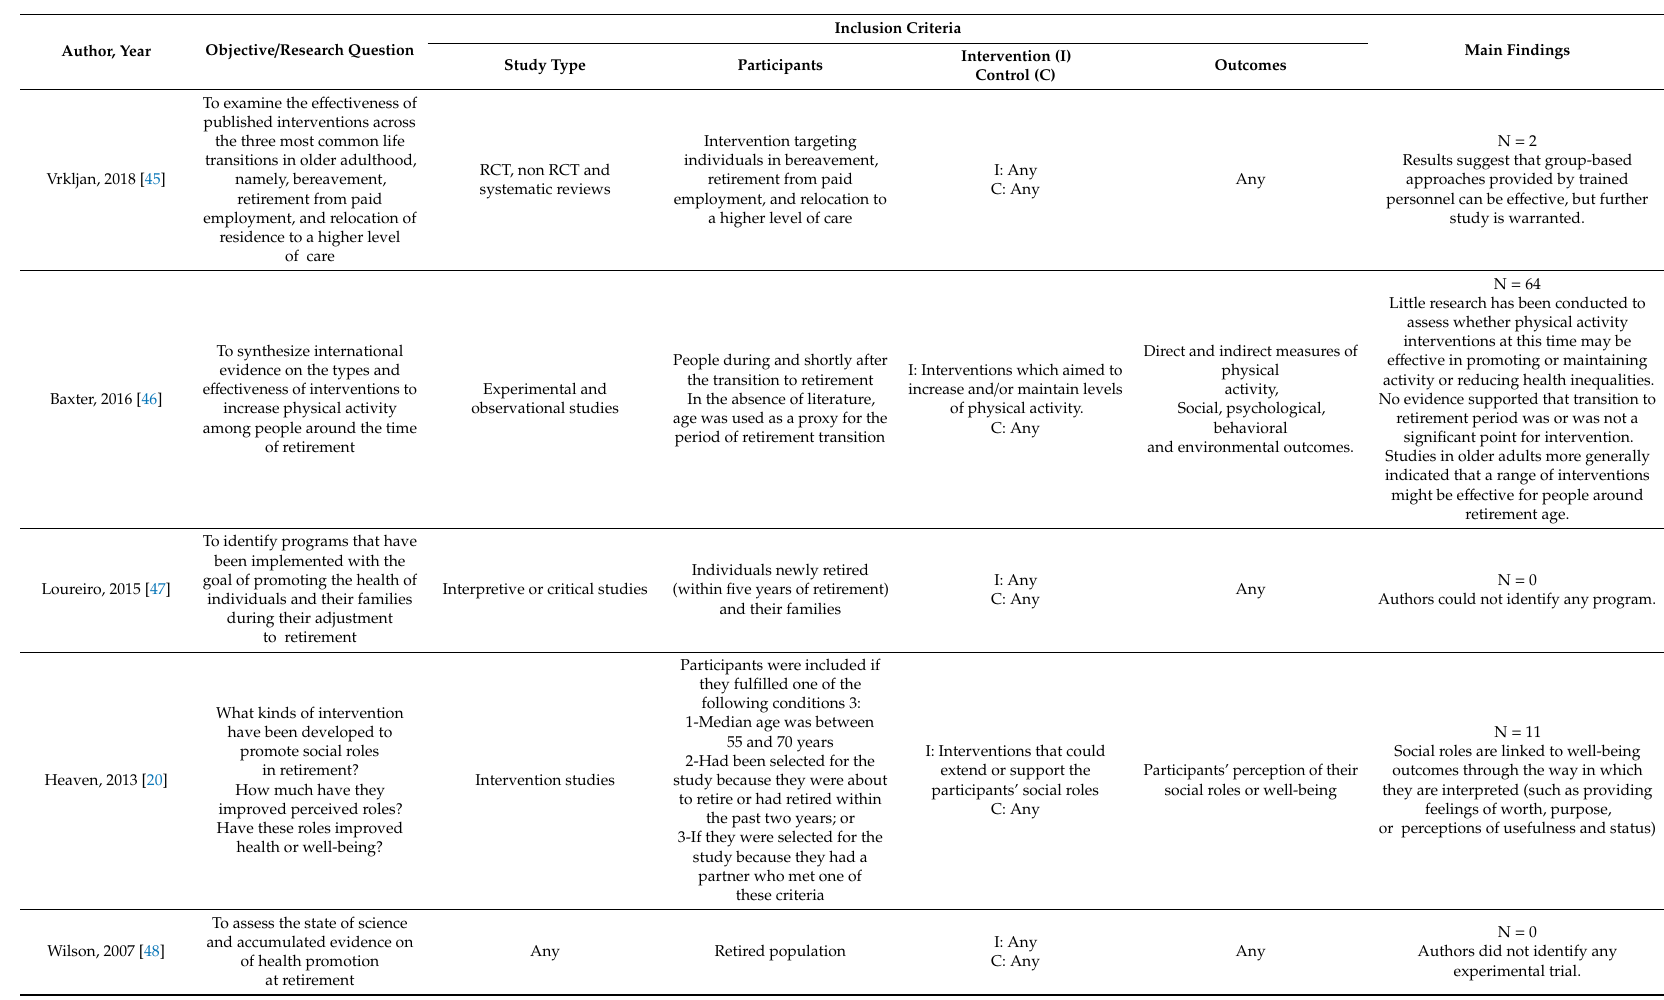
Table 3. General characteristics of systematic